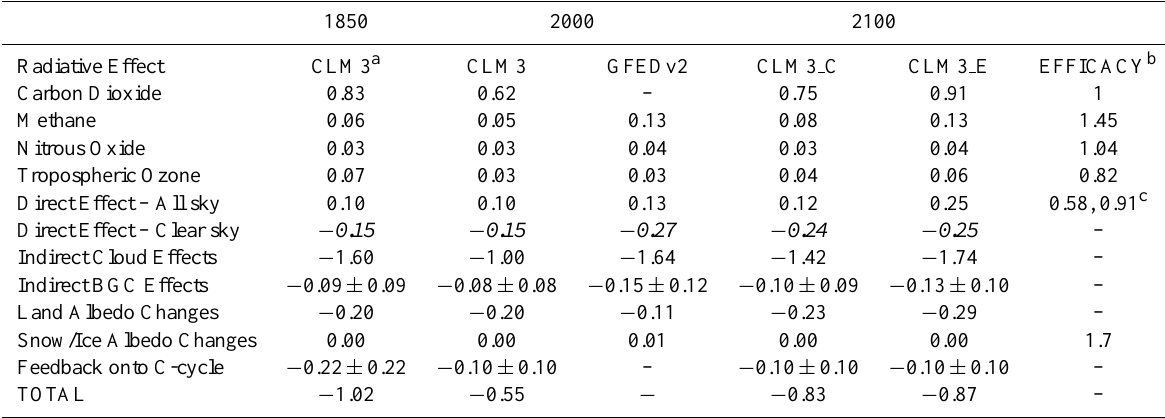
a Acronyms indicate the set of fire emissions used to compute the forcings. CLM3 indicates that the fires were predicted by the Community Land Model version 3.5 with atmospheric forcing from the Community Climate System Model (CCSM), denoted as “ C”, or from ECHAM5/MPI-OM, denoted as “ E”. Other present day fire information was taken from the Global Fire Emissions Database (GFEDv2). b Efficacy values were taken from Hansen et al. (2005). c Efficacy for direct effects of black carbon and organic carbon aerosols from fires, respectively.